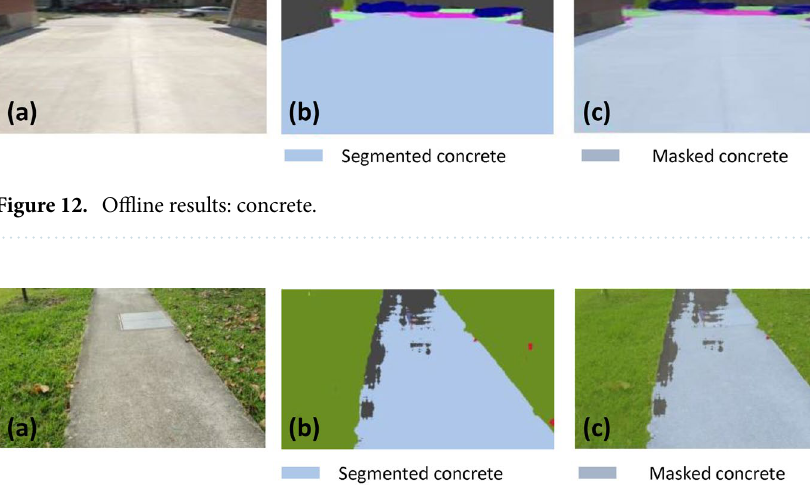
Figure 13. Offline results: concrete.